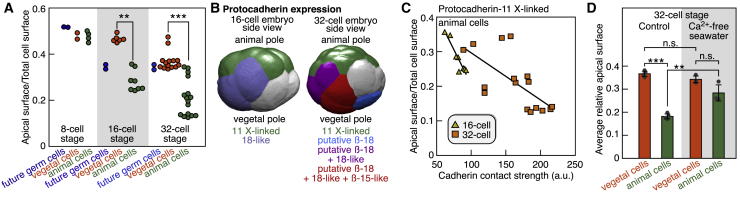
Integration of Imaging and scRNA-Seq Data Identify Patterned Protocadherin Expression(A) Relative apical surface of cells (p = 0.002 at 16-cell stage and p = 7.10−6 at 32-cell stage, Kruskal-Wallis test).(B) Expression territories of four protocadherins.(C) Comparison between the estimated protocadherin-11 X-linked contact strength and the relative apical surface in animal cells (r = −0.94 and p = 0.0006 at 16-cell stage, r = −0.67 and p = 0.004 at 32-cell stage, Pearson’s correlation coefficient).(D) Average relative apical surface of animal and vegetal cells of control embryos and embryos treated with Ca2+-free seawater at 32-cell stage (p = 1.5 10−6 for the animal and vegetal comparison in control embryos, n = 4; p = 0.18 for the animal and vegetal comparison in Ca2+-free-treated embryos, n = 3; p = 0.01 for the animal cells control/Ca2+-free comparison; p = 0.17 for the vegetal cells control/Ca2+-free comparison; n.s., non-significant; two-tailed t test; data represented as mean ± SD).See also Figure S6.